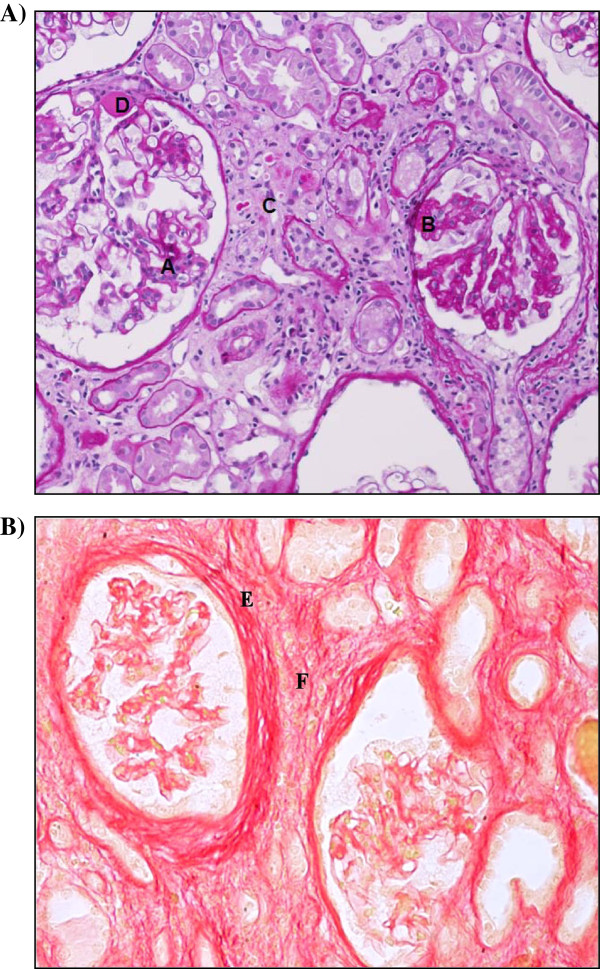
Kidney biopsy. A) PAS staining. Histology of the kidney with characteristic changes of advanced Fabry nephropathy. Please note glomerular segmental sclerosis (A), adhesion and Bowman capsule reduplication (B), tubular atrophy and tubular cell related fibrosis (thickened basement membranes) (C) and arteriolar hyalinosis (D). Original magnification 63×. Courtesy of Prof. Justus Müller, Department of Pathology, University Hospital of Würzburg, Würzburg, Germany. B) Sirius red staining of collagen fibers illustrates peri-glomerular fibrosis (E) and interstitial fibrosis (F). Original magnification × 20.